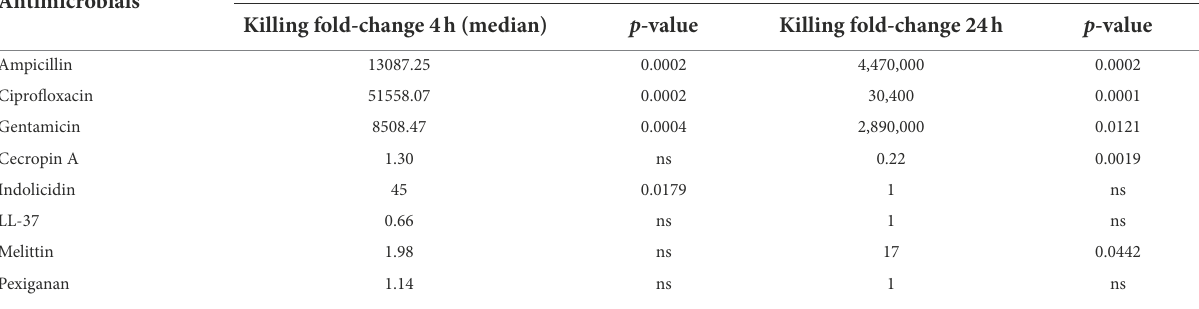
TABLE 3 Killing fold-change of Staphylococcus aureus SH1000 growing exponentially versus stationary phase cultures and their comparative statistical difference (Welsh’s test).